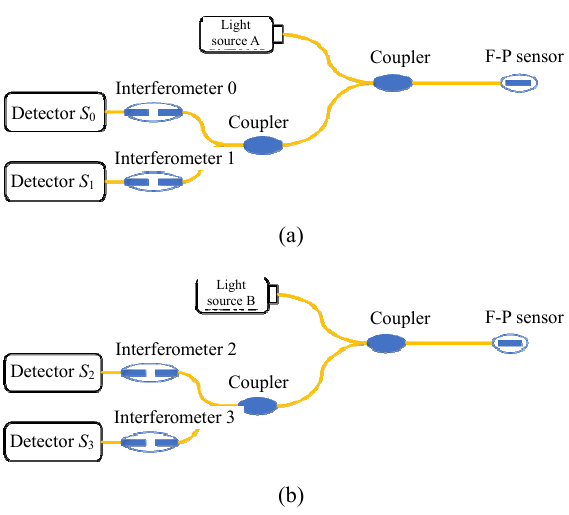
Fig. 1 Design drawing of the optical system: (a) when using the light source A and (b) when using the light source